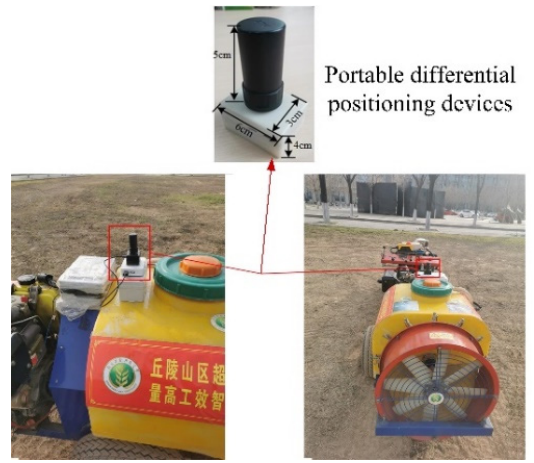
Figure 15. Portable differential positioning devices.